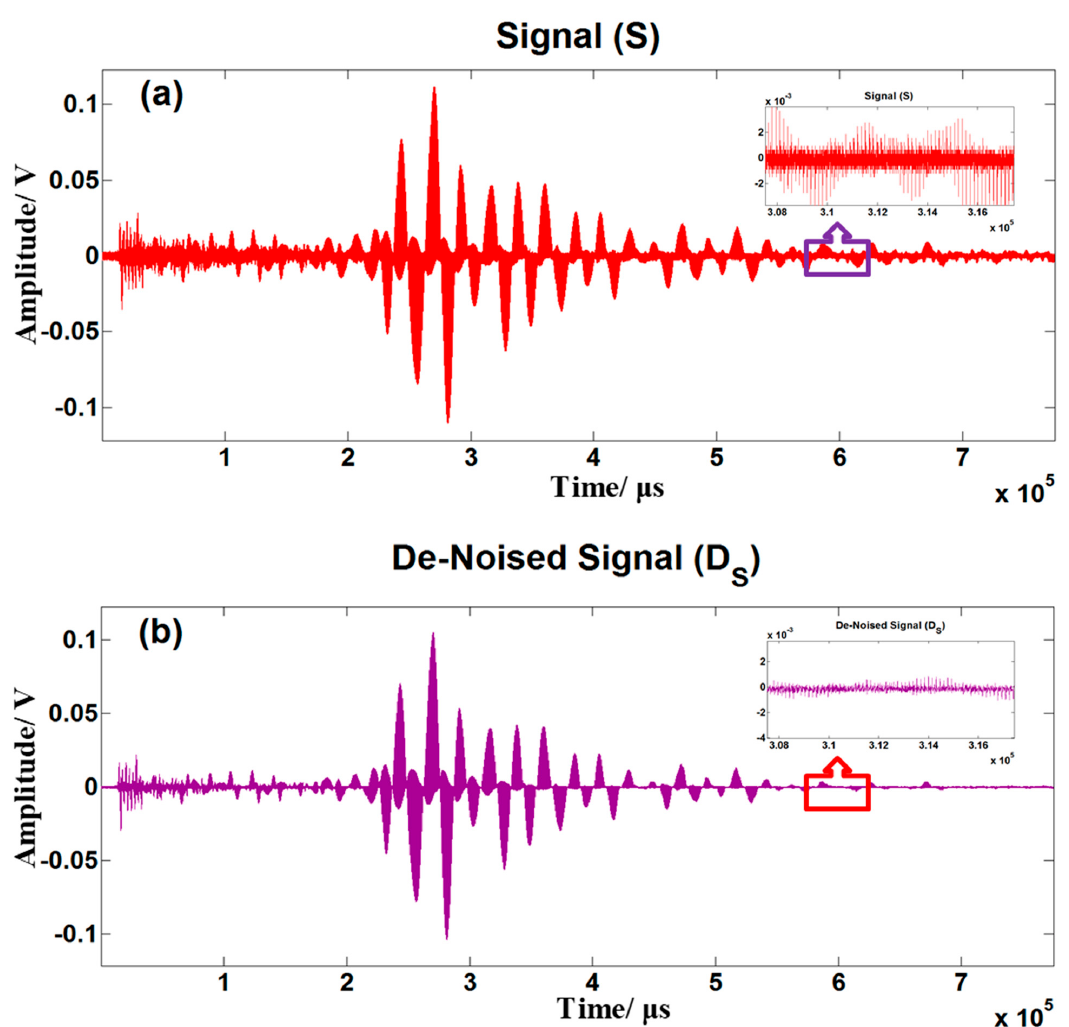
Figure 7. Denoising method for a typical signal of the acoustic emission of carbon steel in NaHCO 3 + NaCl solution. ( a ) Signal before denoising, ( b ) signal after